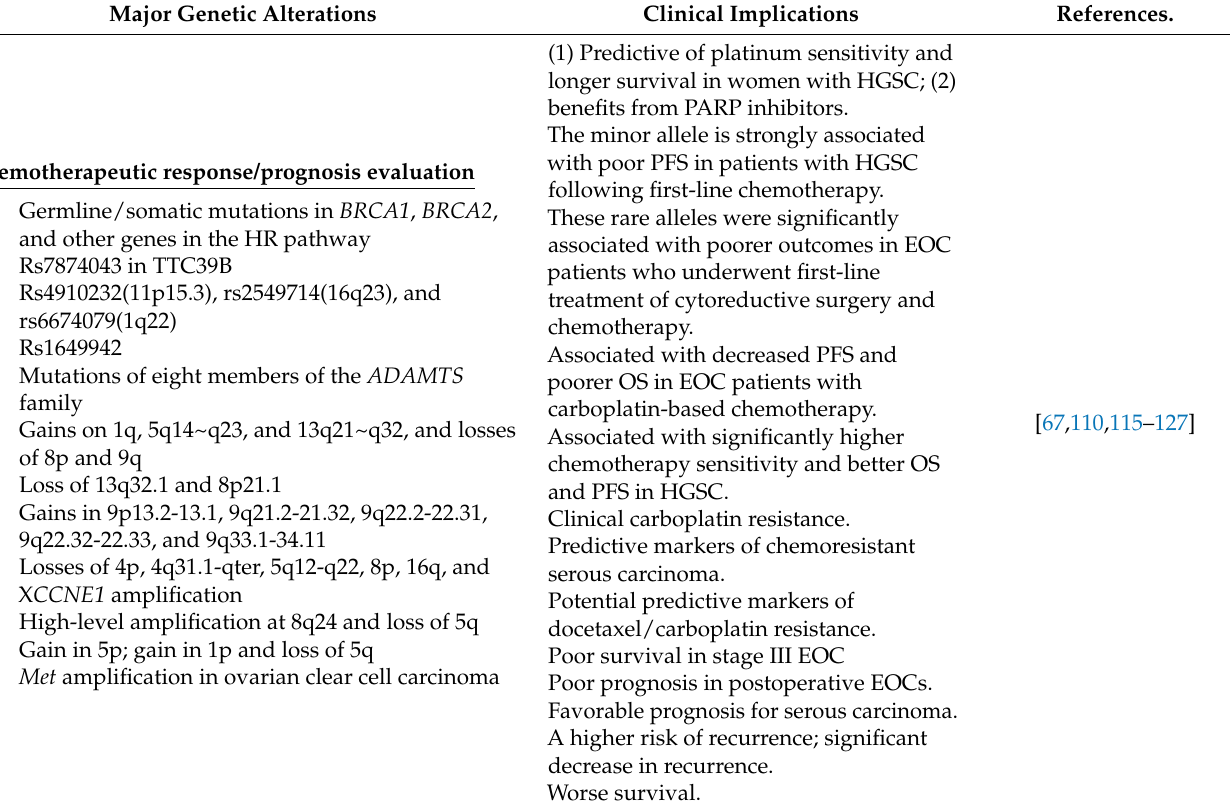
Table 3. Summary of selected genetic alterations and therapeutic monitoring in ovarian carcinomas. Major Genetic